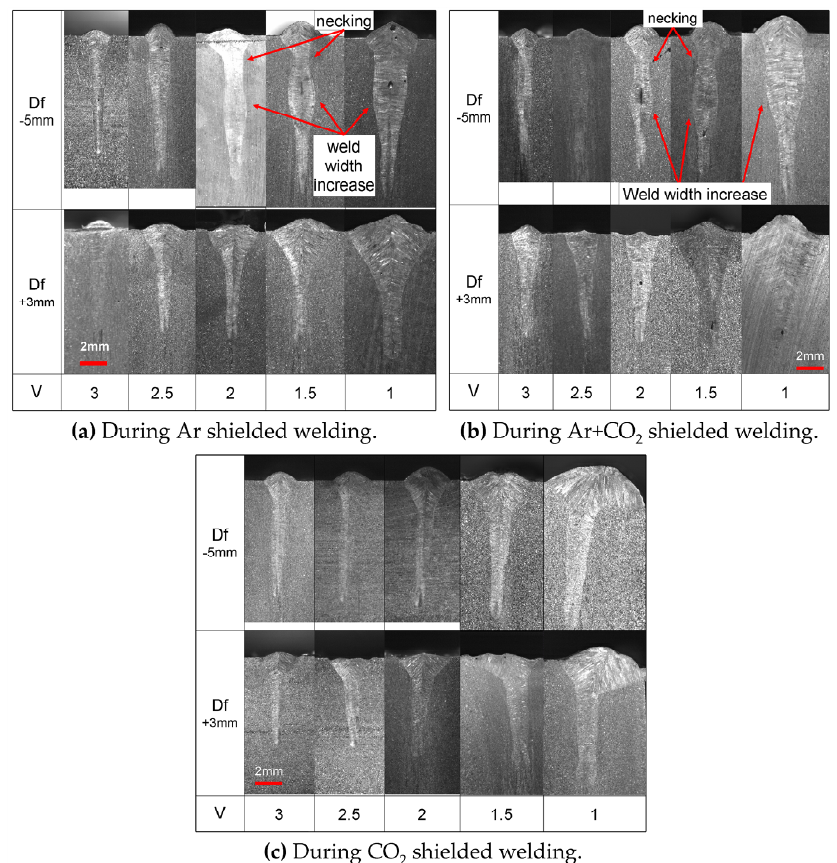
Figure 5. Cross section geometry of Ar, Ar + CO 2 and CO 2 shielded weld joints under different V and Df . ( a ) during Ar shielded welding; ( b ) during Ar + CO 2 shielded welding; ( c ) during CO 2 shielded welding. (All cross-sections have the same scale of 2 mm).